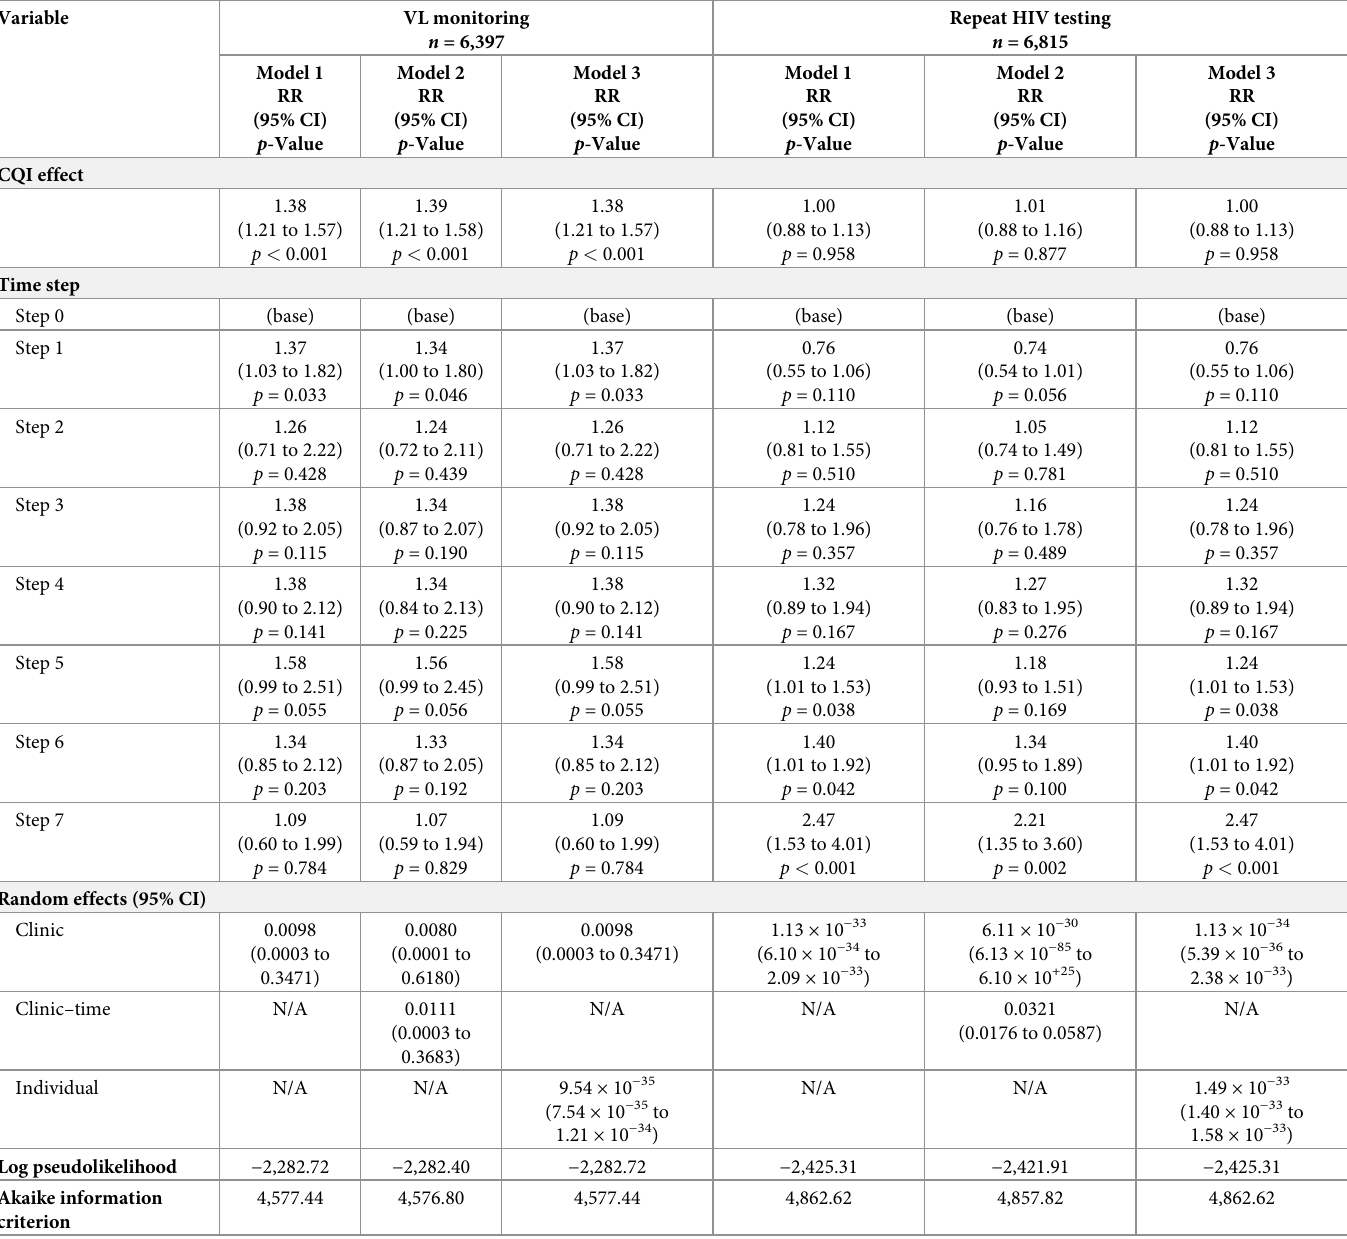
Table 4. Regression models for HIV VL monitoring and repeat HIV testing: RR.